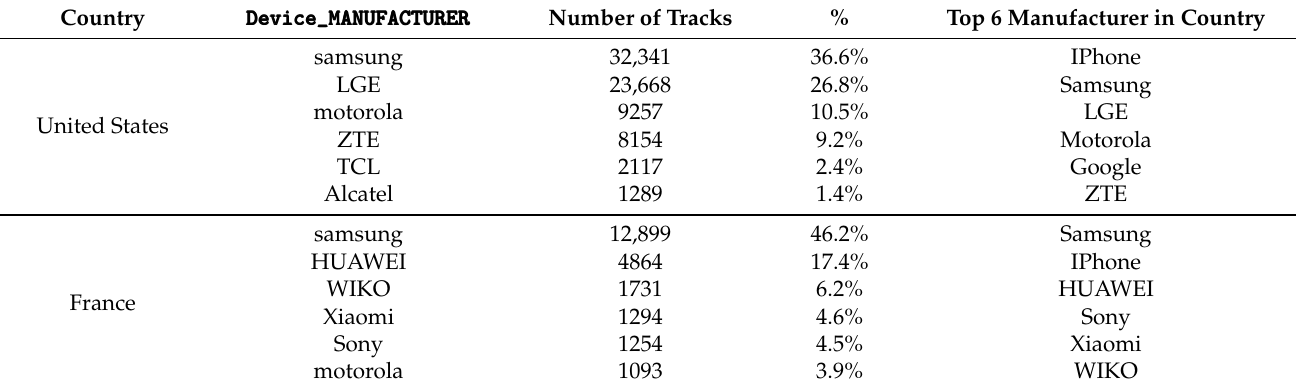
Table 6. Top 6 smartphone manufacturers ( ‘device_manufacturer’ , case-insensitive) for USA and France between August 2017 and August 2020. Top 6 manufacturers data are from Statcounter Global Stats website (licensed under a Creative Commons Attribution-Share Alike 3.0 Unported License) [40].